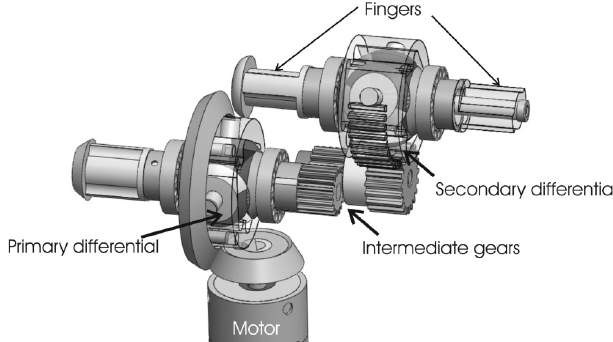
Figure 4. The use of a pair of di ff erentials to create equalising mechanism across two